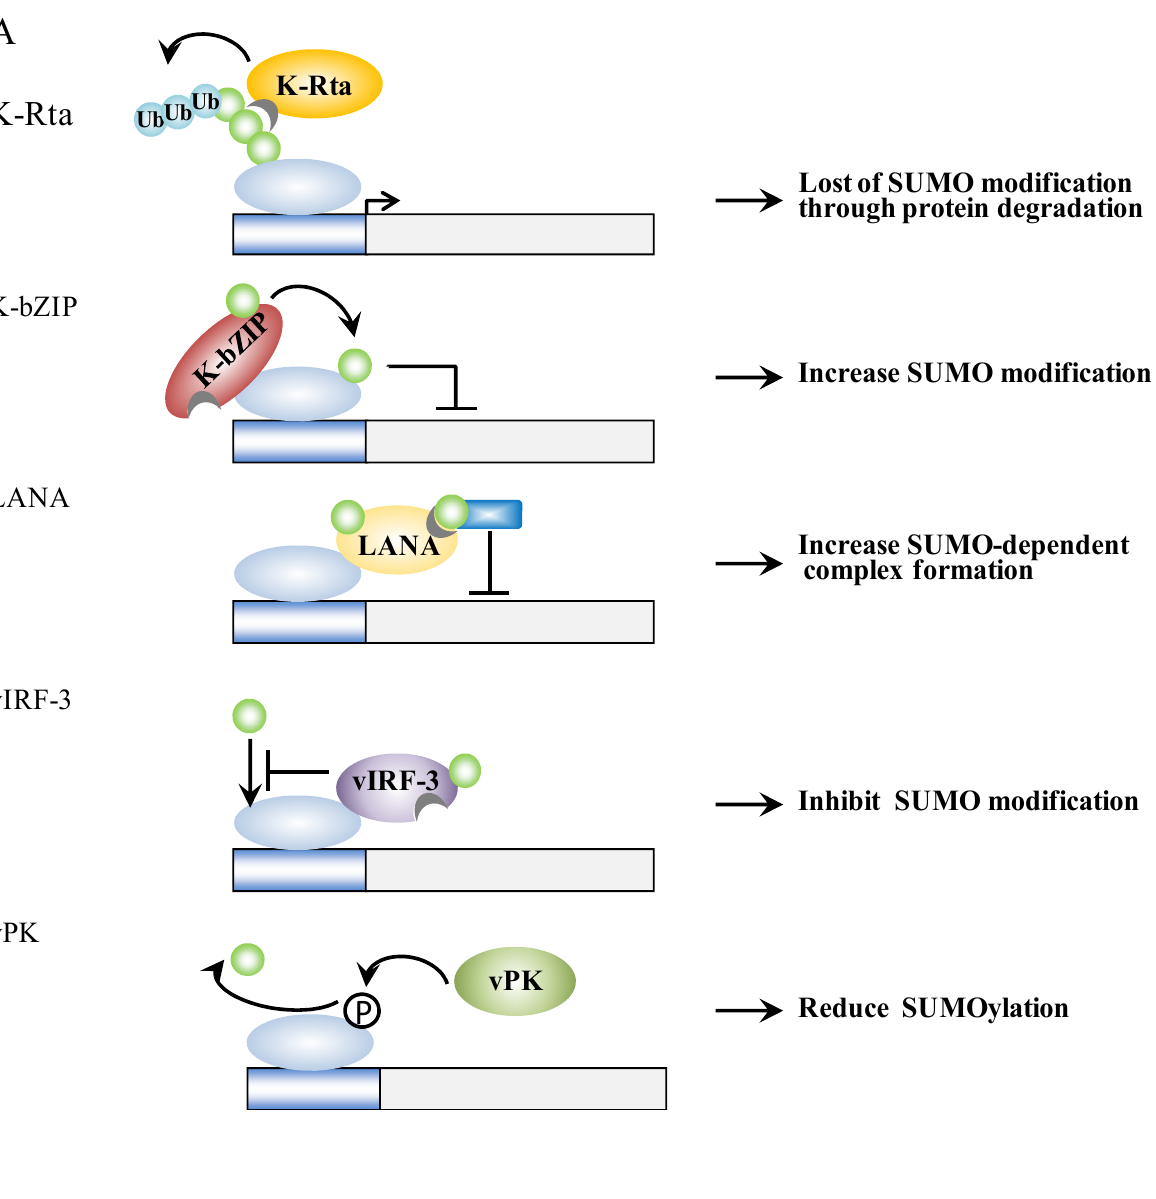
Figure 5. A schematic representation of genome ( A ) and PML-NB ( B ) regulation by KSHV viral proteins. ( A ) K-Rta induces SUMO-dependent ubiquitin-mediated proteasome degradation of SUMO modified proteins. K-bZIP mediates SUMOylation of interacting proteins. LANA elicits a recruitment of SUMO-modified protein. vIRF-3 inhibits the SUMOylation of interacting proteins. Phosphorylation of target protein by vPK causes reduction of SUMO modification; ( B ) K-bZIP colocalizes with PML in the PML-NB. K-bZIP sumoylates p53 and recruits p53 to the PML-NB. K-Rta functions as a STUbL by ubiquitinating SUMO chains on PML, which then induces the degradation of these sumoylated PML molecules. vIRF-3 promotes a SUMO dependent ubiquitylation of PML and this induces PML degradation and PML-NB disruption in a SIM-dependent